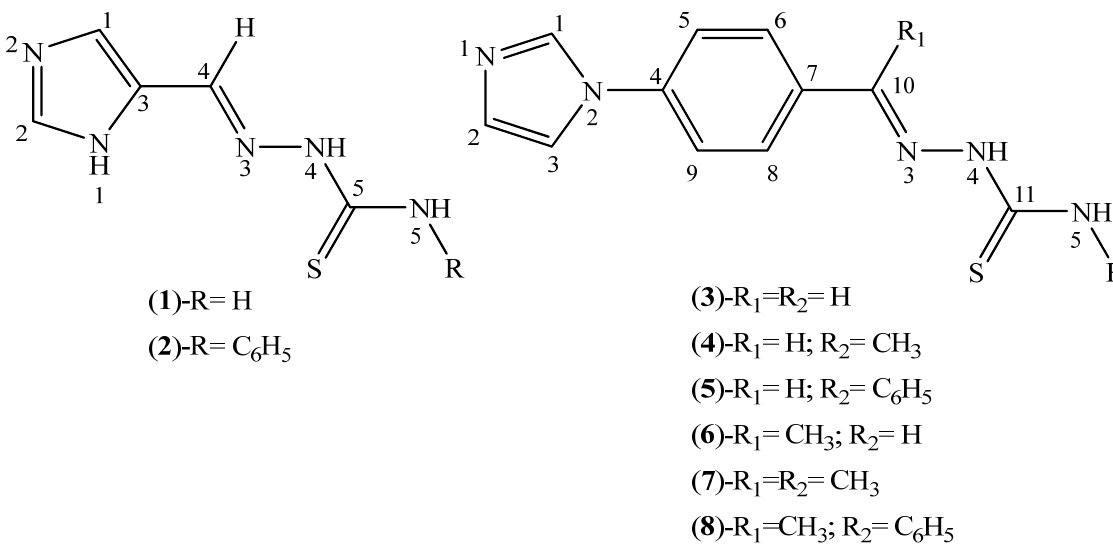
Figure 1. Generic representation for imidazole-derived